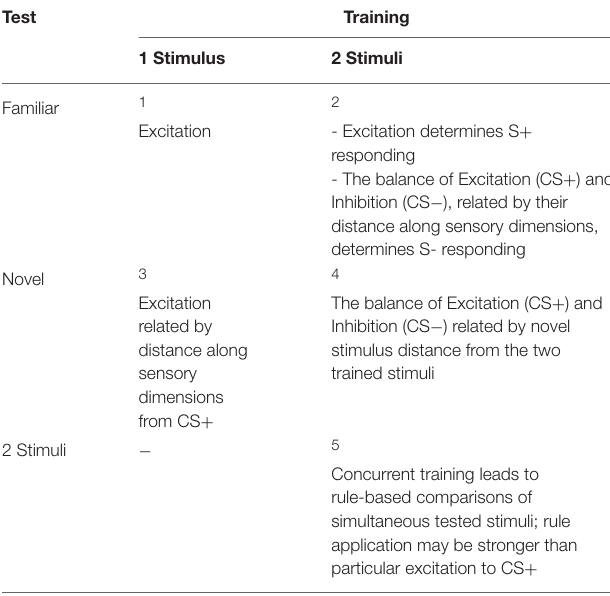
TABLE 3 | Learning